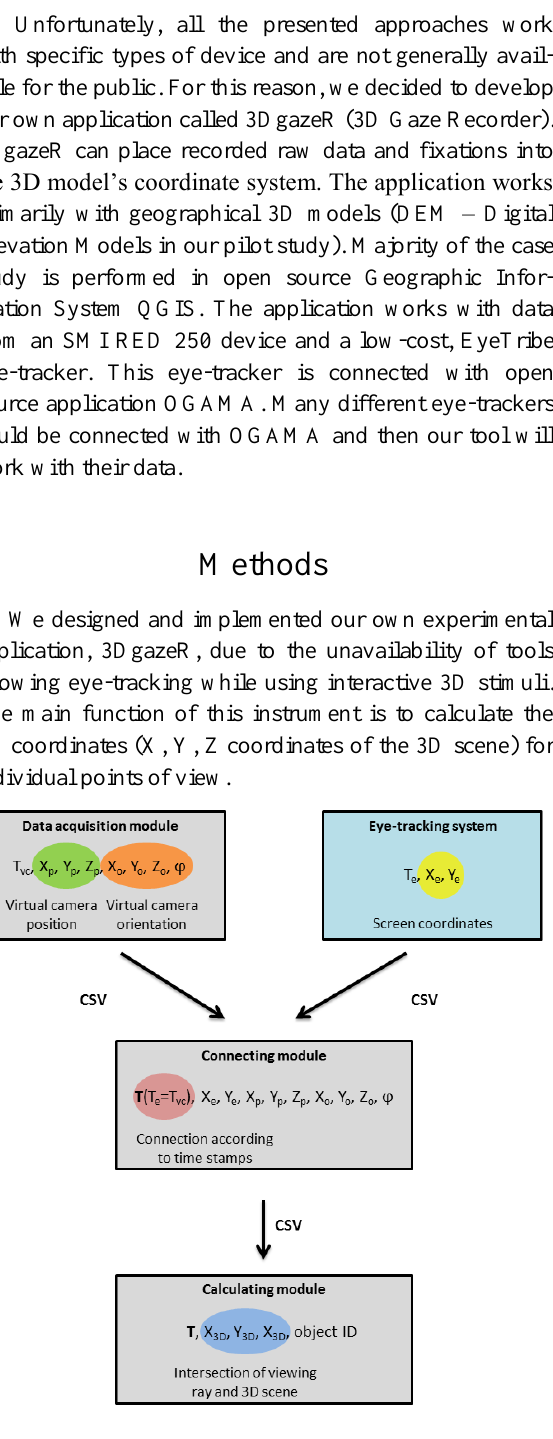
Fig. 1. Schema of 3DgazeR